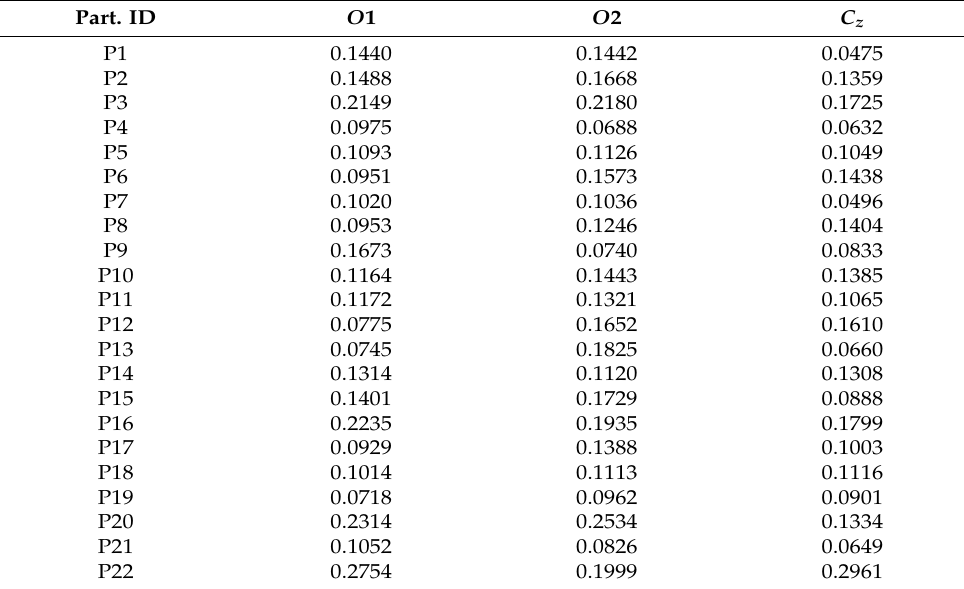
Table 1. Mutual Information computed from the three channels with the output features.